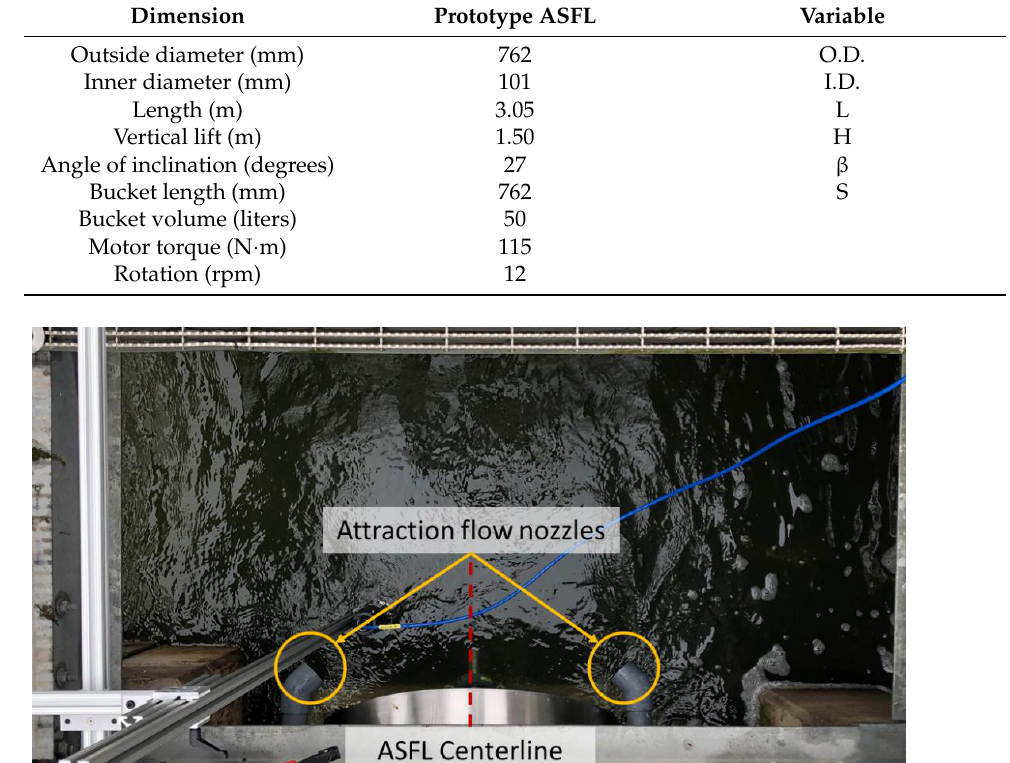
Figure 2. ASFL geometry and 3-dimenssional rendering (inset). Note, the ASFL entrance was submerged by at least 50% but never fully submerged during the testing period. Table 1. Dimensions and characteristics of the ASFL depicted in Figure 2.